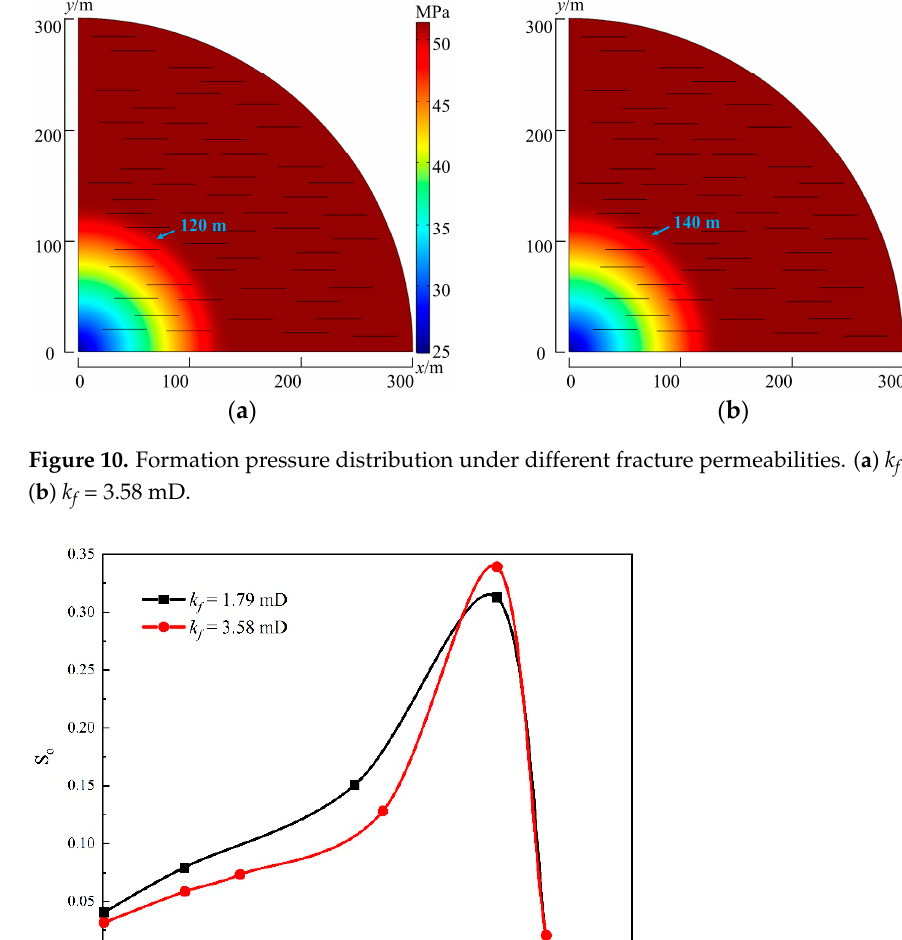
Figure 10. Formation pressure distribution under different fracture permeabilities. ( a ) k f = 1.79 mD, ( b ) k f = 3.58 mD.